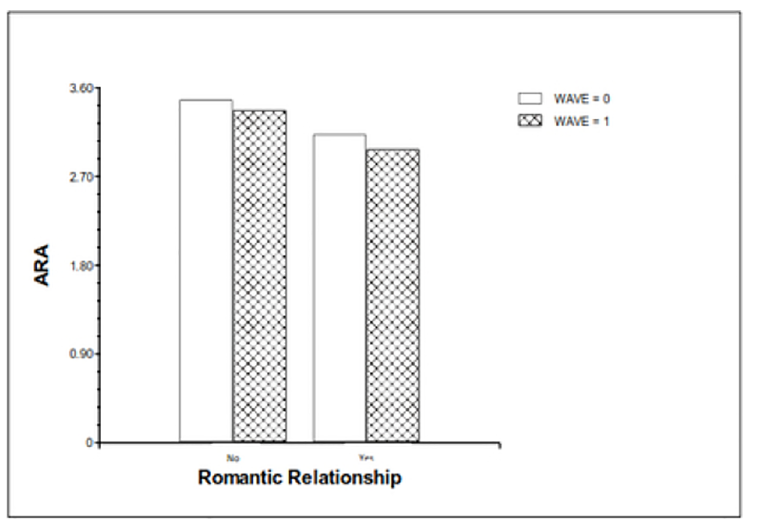
Fig 1. ARA and engagement in a romantic relationship at 16 and 18